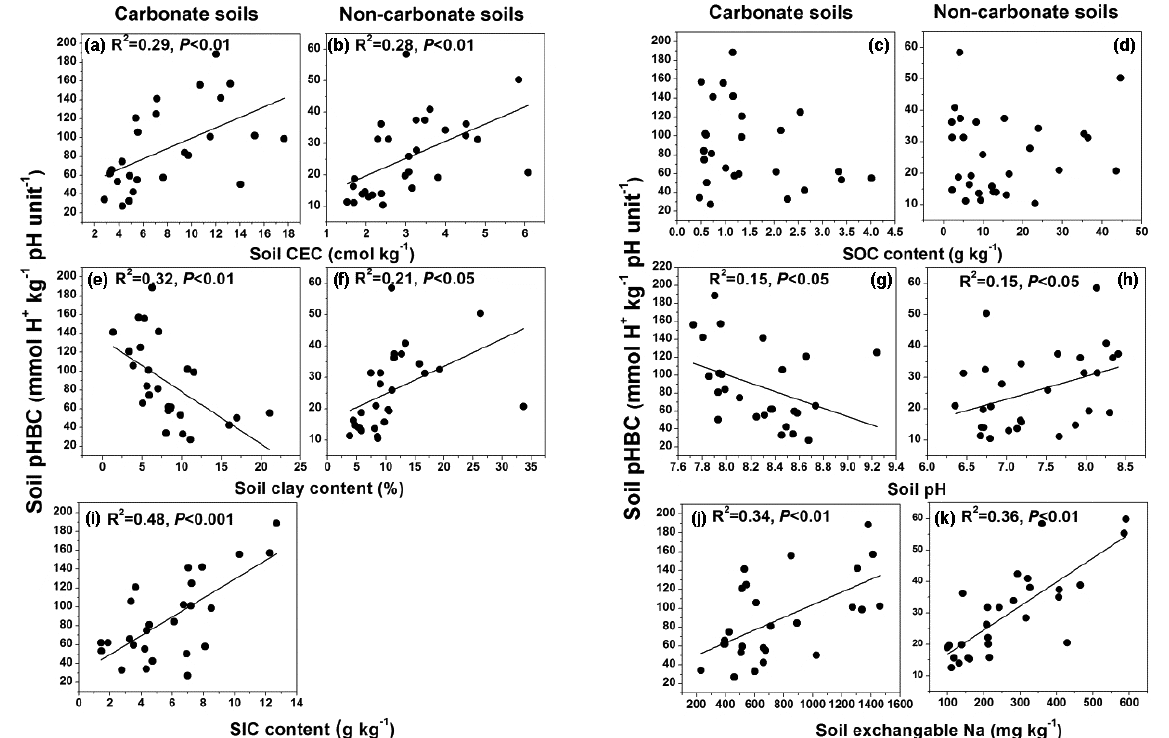
Figure 2. Relationships between soil pH buffering capacity (pHBC) and soil variables (cation exchange capacity (CEC), soil organic carbon (SOC), soil clay content, soil pH, soil inorganic carbon (SIC), and soil exchangeable sodium (Na)) in the carbonate-containing soils and non-carbonate-containing soils. All the regression results can be found in Table 2.